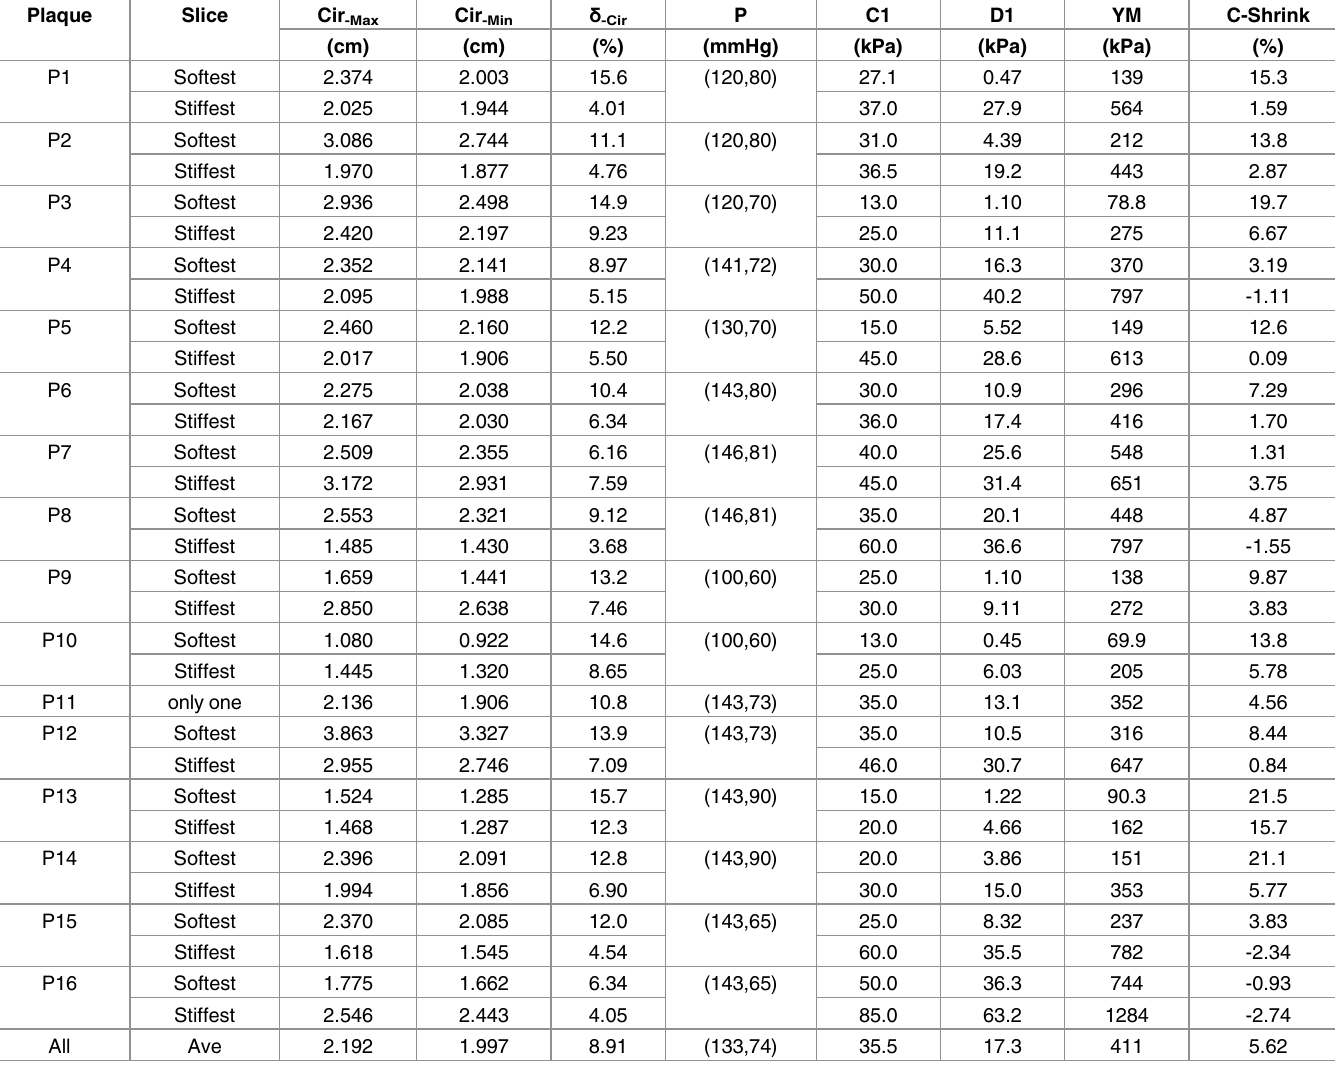
Table 2. Maximum and minimum circumferences, pressure, material parameter and circumferential shrinkage values of the softest and stiffest slices from 16 plaque samples. Plaque